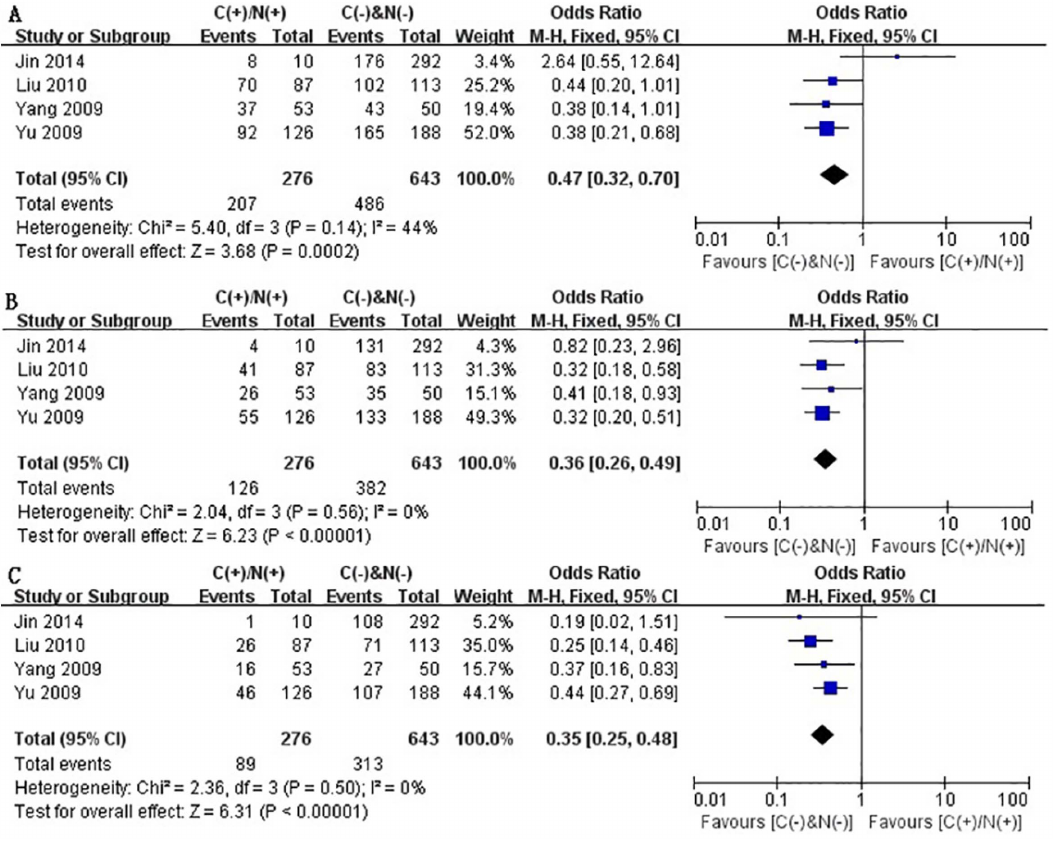
Figure 3. Forest plot of odds ratio for the association of b -catenin expression in cytoplasm and/or nucleus with1-year (A), 3-year (B) and 5-year (C) recurrence-free survival.